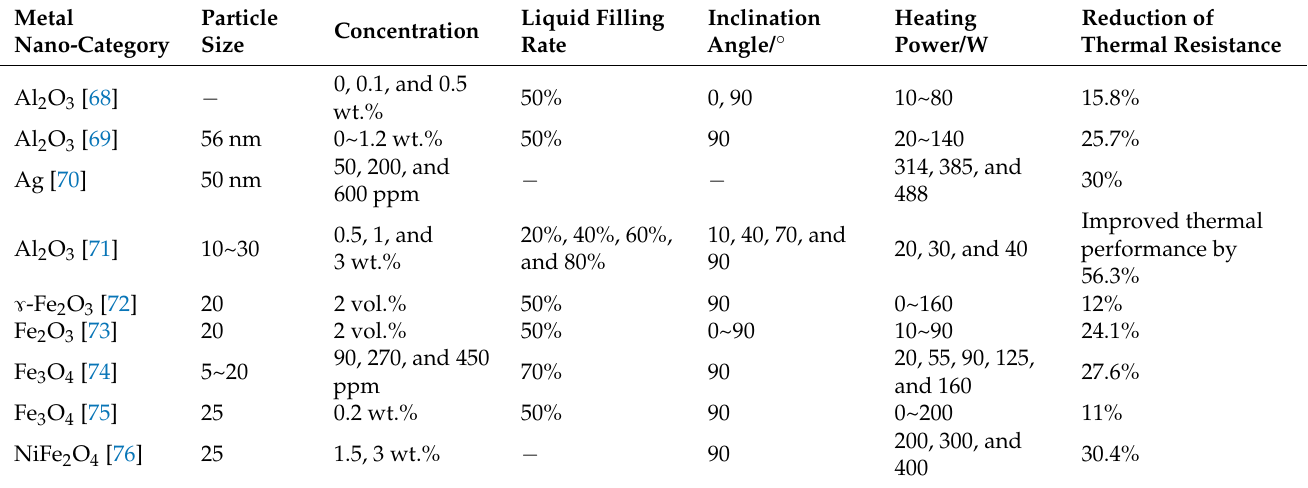
Table 1. Thermal properties of metal